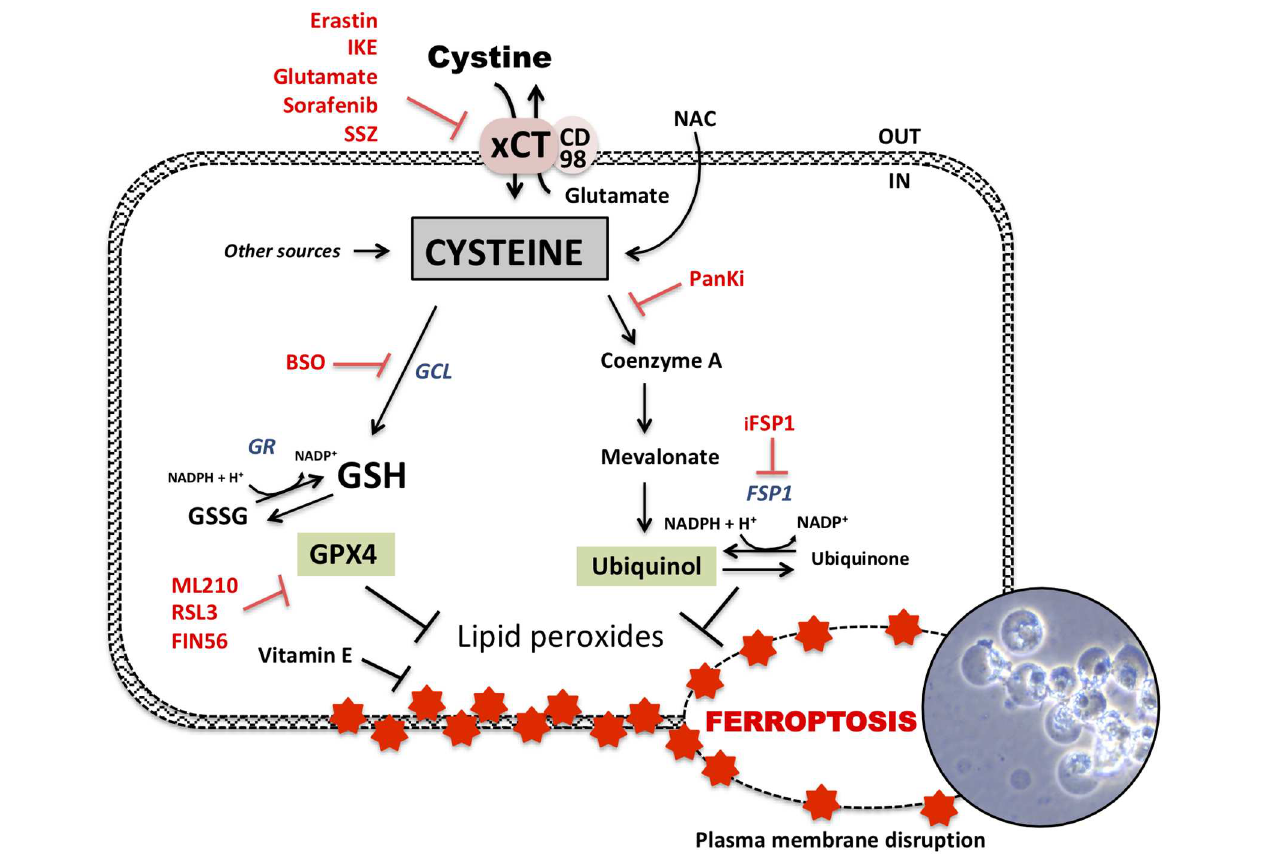
FIGURE 2 | Glutathione dependent and independent ferroptosis axis. Ferroptosis-cell death is dependent of accumulation of lipid peroxides in the membrane leading to its disruption and cell bubbling (photography representing xCT-KO cells dying by ferroptosis). GSH-dependent axis follows cysteine-dependent import via xCT and GSH synthesis. Some of up-to-date known inhibitors of xCT are erastin, imidazole ketone erastin (IKE), high extracellular glutamate but also sorafenib or sulfasalazine (SSZ). Cysteine is the rate limiting component of GSH synthesis via glutamate-cysteine ligase (GCL). This GSH biosynthesis can be inhibited by buthionine sulfoximine (BSO). GSH can be reduced via GSH reductase (GR) and then used as a cofactor by GSH peroxidase 4 (GPX4) to detoxify lipids peroxides. GPX4 can be inhibited by different inhibitors such as RSL3, ML210, and FIN56 to induce ferroptosis. GSH-independent axis follows detoxification of lipid peroxides by ubiquinol leading to its oxidation to ubiquinone. Ferroptosis suppressor protein 1 (FSP1) is responsible of the regeneration of ubiquinone to ubiquinol and can be interrupted by “inhibitor of FSP1” (iFSP1). Acetyl-CoA is a precursor of ubiquinol and mevalonate pathway. Cysteine is potentially implicated in ubiquinol synthesis via pantothenate pathway which uses cysteine for acetyl-coA synthesis. Pantothenate synthesis is inhibited by pantothenate kinase inhibitors